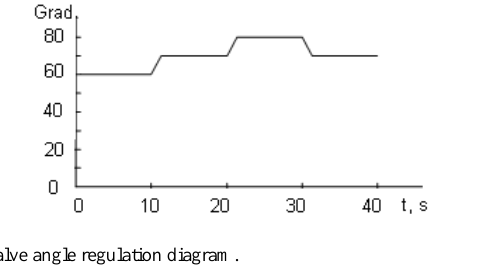
Fig. 6. Valve angle regulation diagram.